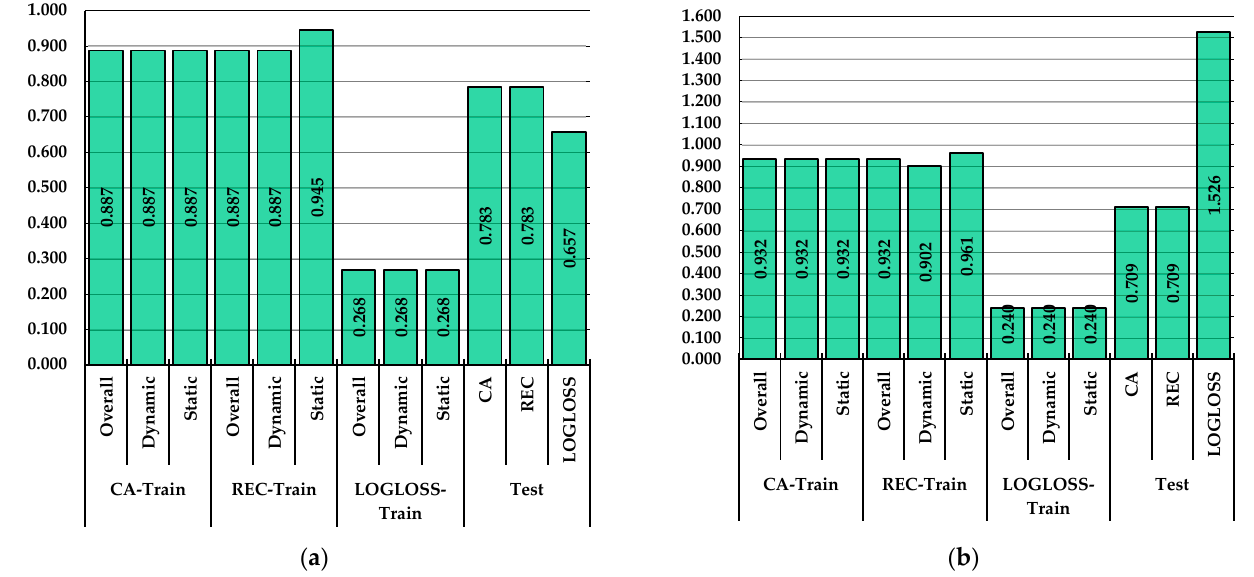
Figure 6. Classification performance in the training and testing phases to differentiate dynamic from static work: ( a ) by a MLPBNN machine learning algorithm with α set at 0.001; ( b ) by a RF machine learning algorithm with number of trees set at 10,000.